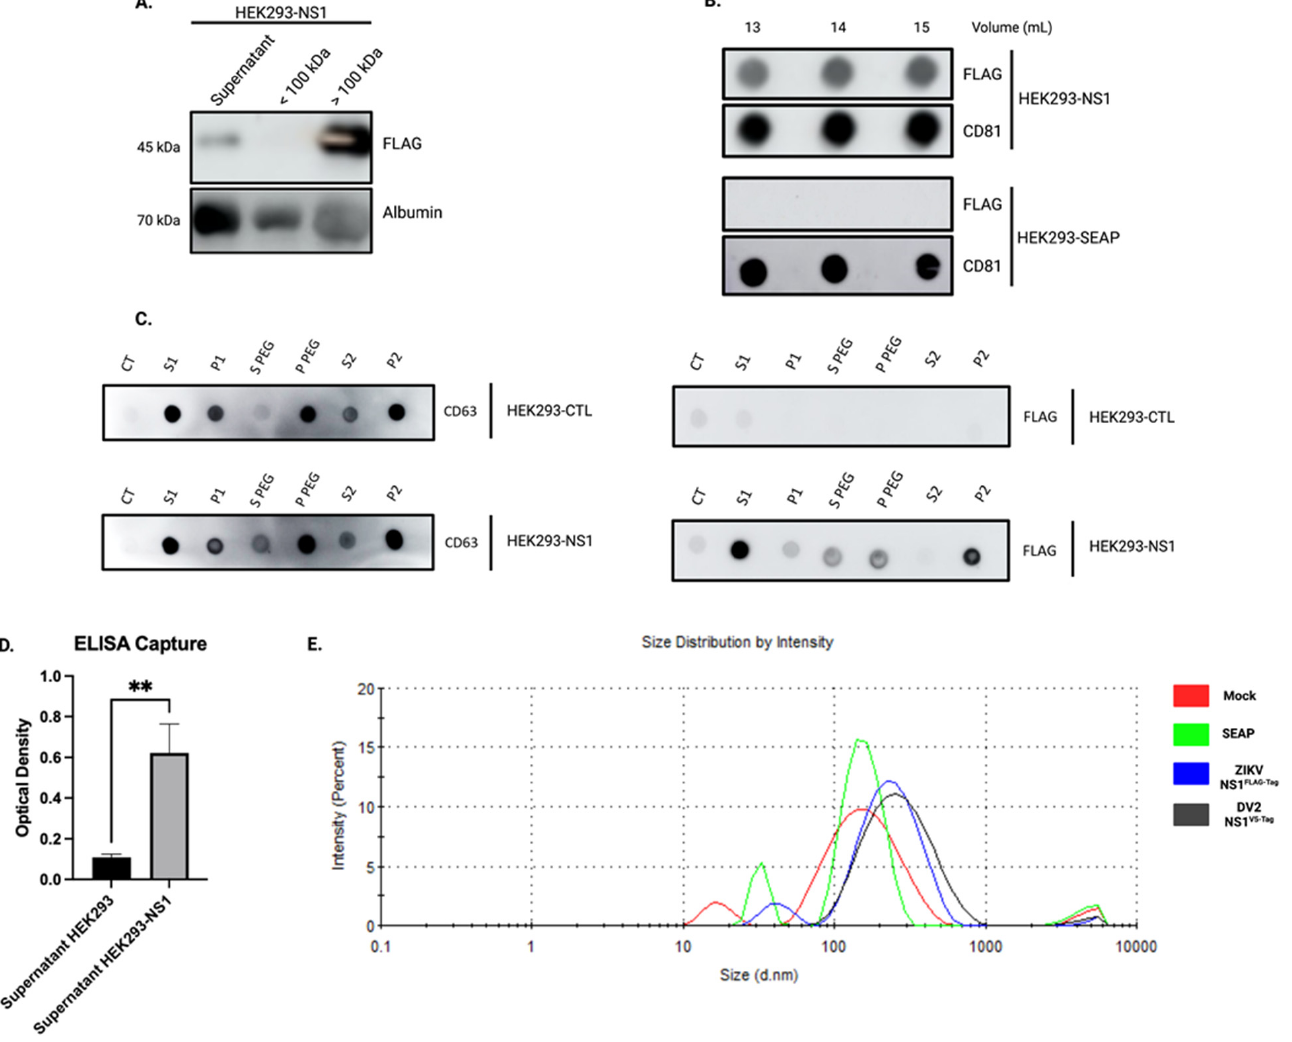
Figure 3. ZIKV-NS1 FLAG-tag is present in the exosome fraction. ( A ) Western blot analysis of HEK293- NS1 supernatant following ultrafiltration. Mouse anti-FLAG antibody was used to detect ZIKV- NS1 FLAG-tag , while the detection of albumin served as protein loading control. ( B ) Dot blot analysis of putative exosome fractions. After the ultrafiltration step, size exclusion chromatography was carried out on the >100 kDa fraction. Detection of ZIKV-NS1 FLAG-tag was achieved using a mouse anti-FLAG antibody, whereas CD81 was chosen as a marker for exosomes. ( C ) CCS containing CD63-positive EVs and secreted ZIKV-NS1 FLAG-tag (S1) were treated with PEG and centrifuged to obtain a pellet enriched in EVs. CD63 was found in the first pellet (P PEG) and after the second ultracentrifugation step (P2), validating the enrichment of exosomes which were also found associated with ZIKV-NS1 FLAG-tag . ( D ) ELISA capture of the exosomes in the supernatant of HEK293-ZIKV-NS1 FLAG-tag versus control. Exosomes were captured by an anti-CD81 antibody coated on Maxisorp ® plate. NS1 FLAG-tag protein was detected using a mouse anti-FLAG antibody. Ordinary one-way ANOVA test was performed using GraphPad Prism, ** p < 0.001. ( E ) DLS analysis of the exosomal fractions with the proportion of vesicles by size graph and the corresponding z-average-table (Table 2). Table 2. Overexpression of ZIKV and DENV2 NS1 lead to an increase in exosomes size. Sample Z-Average (d.nm) Standard Deviation